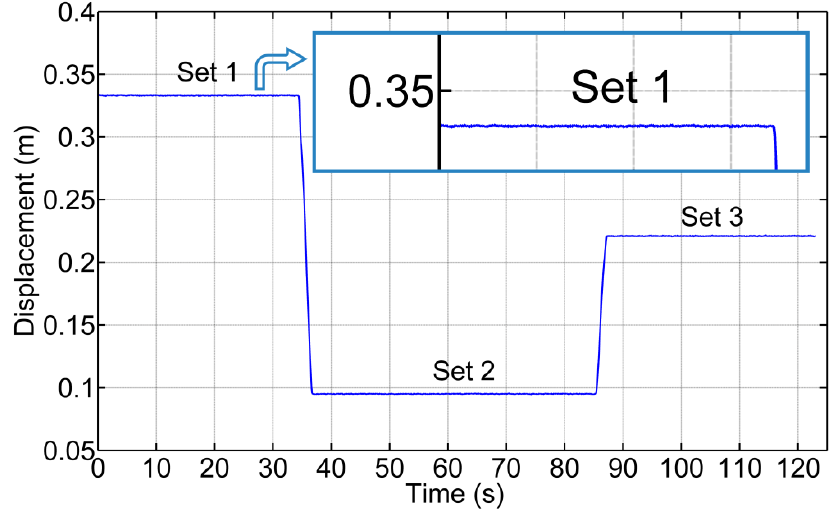
Figure 16. Measuring the position of the sensor in static tests.